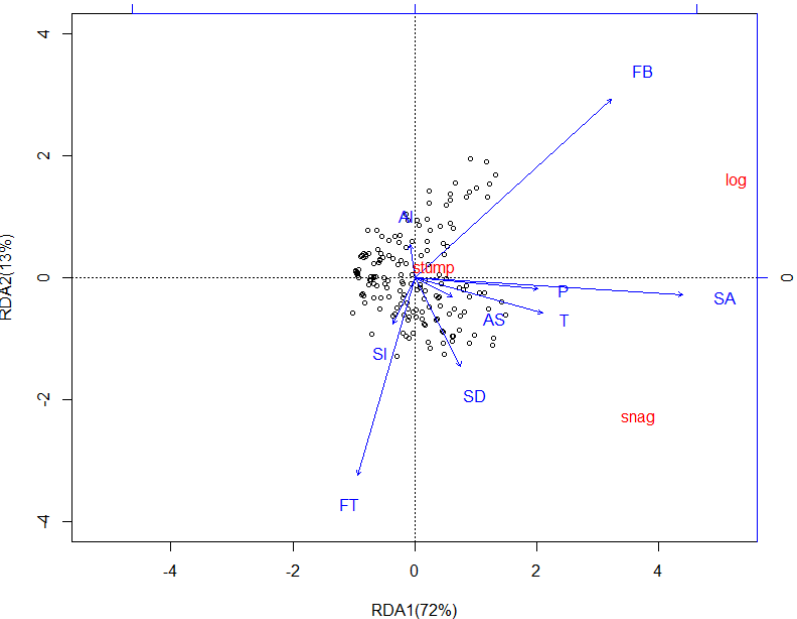
Figure 8. Redundancy Analysis (RDA) showing the relationships between the CWD compositions (logs, snags, and stumps) and effect factors in the different samples on the Huoditang Experimental Forest Farm in the Qinling Mountains (China). Arrows indicate effect factors: FT = Forest type; FB = Forest biomass; AS = Aspect; Al = Altitude; SA = Stand age; Sl = Slope; SD = Stand density; T = Annual average temperature; P = Annual average precipitation. CWD composition names in red indicate the composition’s vector